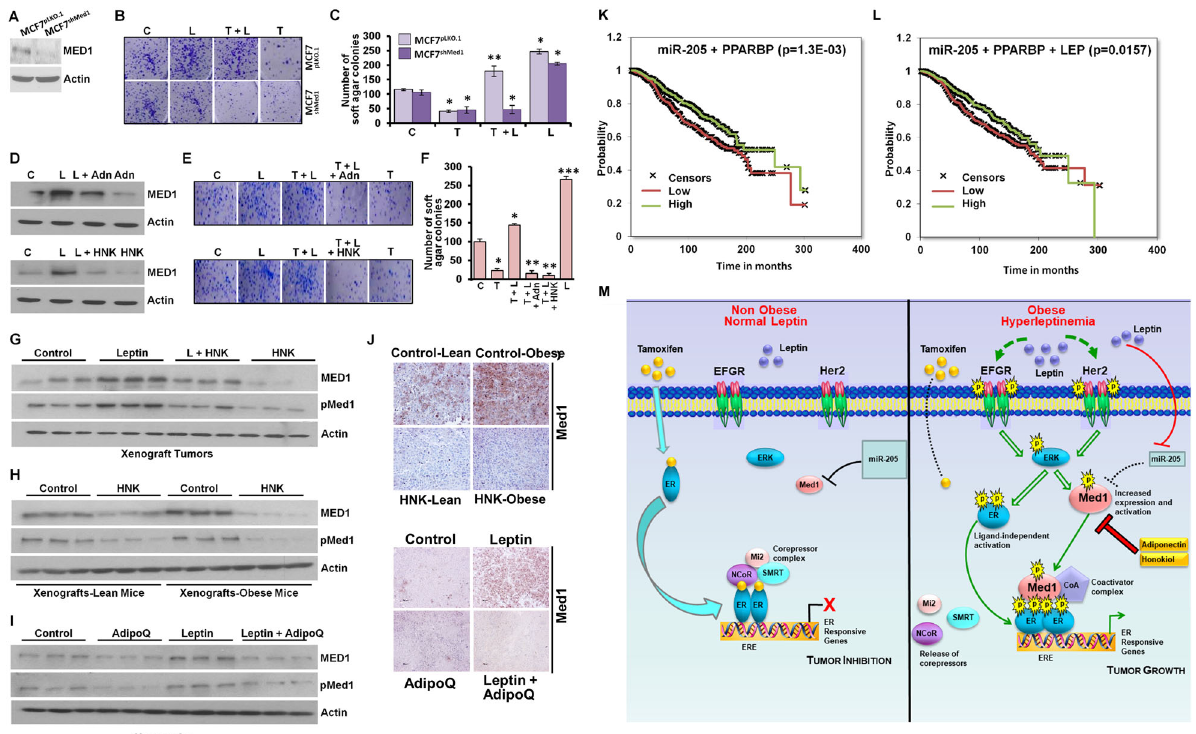
Fig. 6 Bioactive strategies effectively improve the ef fi cacy of tamoxifen in hyperleptinemic state. A Immunoblot analysis of Med1 expression level in stable pools of Med1-depleted (Med1 shRNA ) and vector control (pLKO.1) MCF7 cells. B Clonogenicity assay performed with MCF7-pLKO.1, MCF7 -pMed1 shRNA cells in the presence of leptin and 4-hydroxytamoxifen alone or with combination. C Soft agar assay was performed using MCF7-pLKO.1, MCF7 -pMed1 shRNA cells in the presence of leptin and 4-hydroxytamoxifen alone or in combination. Bar graph shows number of soft agar colonies. D MCF7 cells treated with leptin, adiponectin (10 µg/ml), and Honokiol (HNK) (5 µM) alone or in combination as indicated were subjected to immunoblot analysis for Med1 expression. E , F MCF7 cells were treated with leptin and 4-hydroxytamoxifen alone or combination with adiponectin or HNK as indicated and subjected to ( E ) clonogenicity assay and ( F ) soft-agar colony formation assay. G MCF7 cells-derived tumors were developed in nude mice and treated with Leptin, HNK and Combination. At the end of 6 weeks, tumors were collected and tumor samples ( n = 3/group) were subjected to immunoblot analysis using Med1 and pMed1 antibodies. H Tumor lysate ( n = 3/group) from MCF7-derived lean mice and obese mice treated with HNK were subjected to immunoblot analysis using Med1 and pMed1 antibodies. I MCF7 cells-derived tumors were developed in nude mice and treated with adiponectin, leptin alone and in combination. After 6 weeks, tumors were collected and tumor lysate ( n = 3/group) were subjected to immunoblot analysis using Med1 and pMed1 antibodies. Actin is used as loading control. J Immunohistochemical (IHC) analysis for Med1 in MCF7-derived tumors treated with HNK, adiponectin (AdipoQ) as indicated. Scale bar: 50 µm. K Kaplan – Meier plots of breast cancer recurrences in relation to high miR-205 + low PPARBP. L Kaplan – Meier plots of breast cancer recurrences in relation to high miR-205 + low PPARBP + low Leptin. M Schematic diagram showing the signaling pathways activated in normal leptin and hyperleptinemic state. *** p < 0.0005, ** p < 0.005, * p < 0.05. Data are means ± SD from three